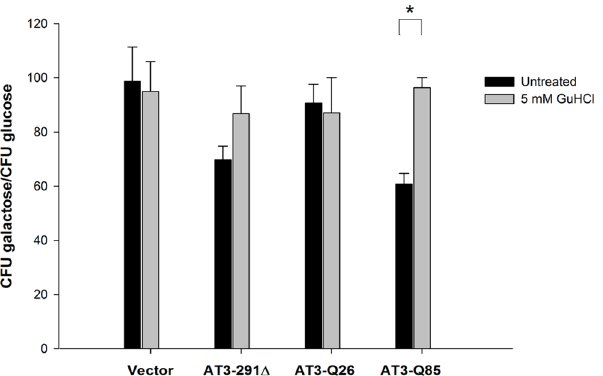
percentage ratio of cells grown under inducing (galactose) versus non-inducing (glucose) conditions. Bars represent standard errors and are derived from at least three independent experiments (P <